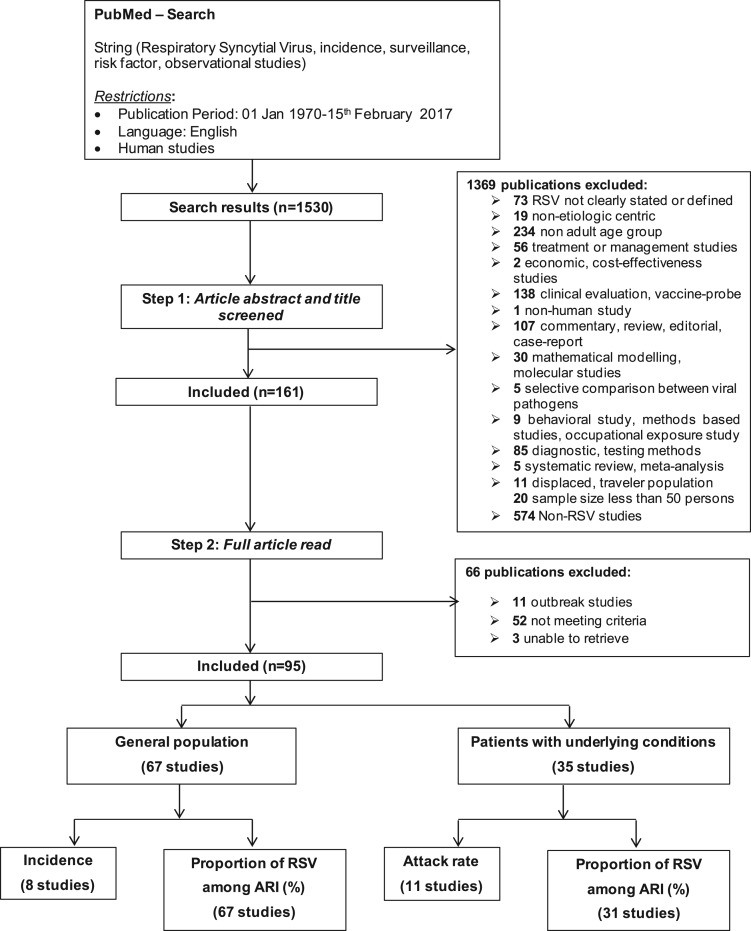
Flow chart of the selection process of articles. *Note that some studies included more than one outcome.